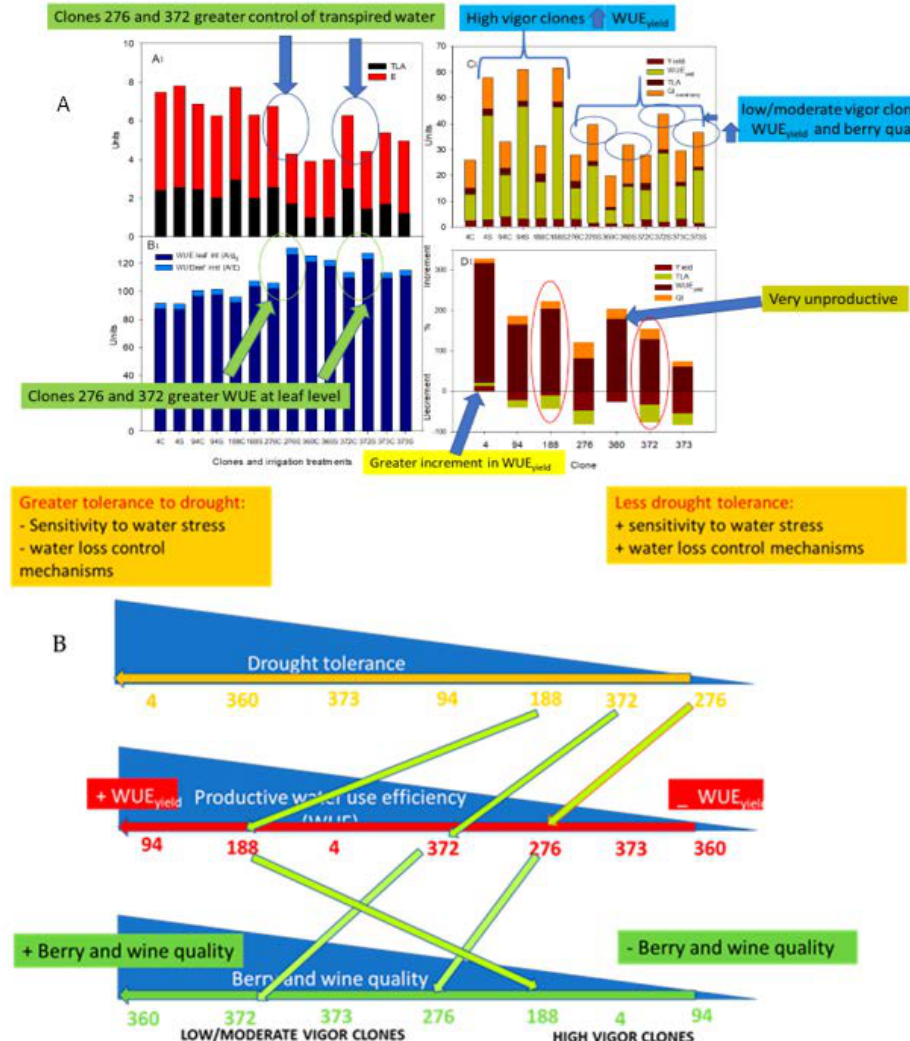
Figure 10. ( A ) Graphics representing changes in control of transpired water ( E , leaf transpiration rate; TLA, total leaf area) for each clone under control and stress conditions ( A ), WUE leaf ( B ) changes in yield, WUE yield , TLA (total leaf area) and QI overall berry ( C ) and increments and decrements for each clone in yield, TLA, WUE and QI between control and stress treatments (irrigation treatments) ( D ) Data average from three years. ( B ). Diagram showing a classification of clones according to three criteria: tolerance to drought, productive water use efficiency, and quality of grapes and wines. Low- vigour clones (372, 276) and high-vigour clone 188 showed an equilibrium among moderate/high yield, drought tolerance, WUE yield , and high berry and wine